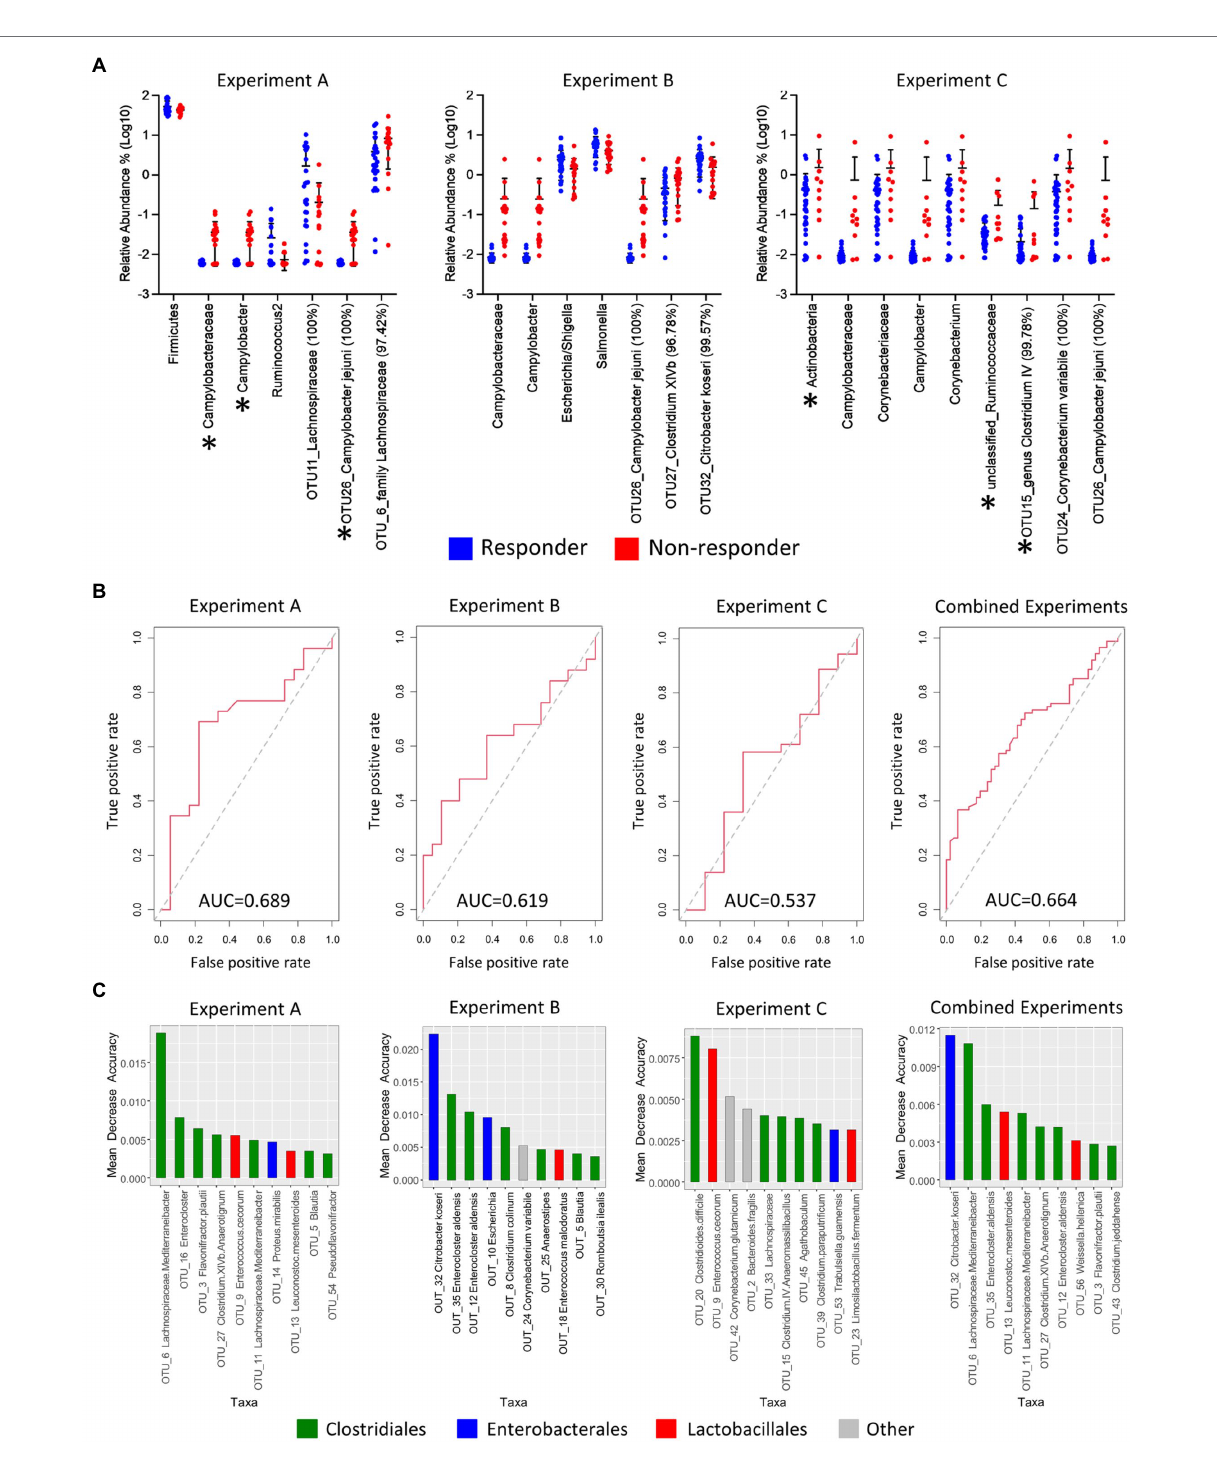
FIGURE 4 | Significant taxonomic changes between responder and non-responder birds, receiver operating characteristics (ROC) plots, and identification of taxa that are predictive of response per experiment. (A) Scatter dot plot of statistically significant differences in taxa between responders and non-responders analyzed by multiple t -tests followed by false discovery rate (FDR) test using two-stage linear step-up procedure of Benjamini, Krieger, and Yekuteli. Lines represent mean and standard deviation. Percentages beside the names refer to percent identity for each taxon. Significance was established at p < 0.05 and q < 0.2. Asterisks indicate significant taxa after FDR. Lines represent mean and standard deviations. (B) ROC plots (using OTUs and excluding Campylobacter from the equation) were generated for the response factor and area under the curve (AUC) was calculated for individual experiments and for all experiments combined using the ROCR package in R statistical software. (C) Bar plots of variance importance per experiment as determined by mean decrease accuracy as part of random forest analyses. OTU, operational taxonomic unit; Un,